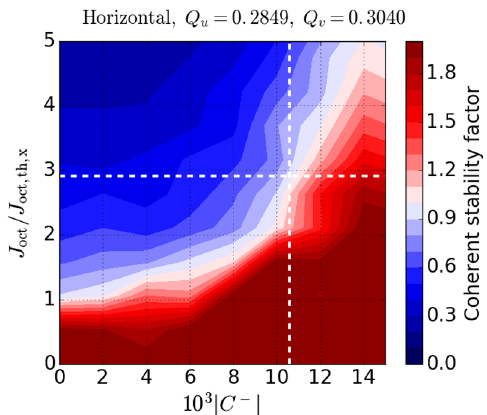
FIG. 12. P Y SSD results for a fixed coupled tune separation of Q ¼ 0 . 0191 . The white dashed vertical line marks the sep ; coupled measured j C − j which corresponds to an increase in the octupole threshold by a factor of